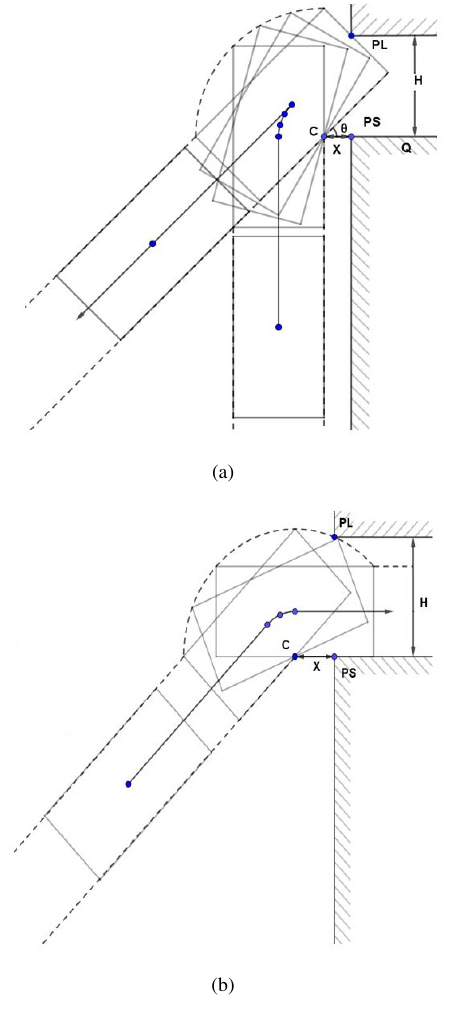
Figure 10. The trajectory of RRB when √ 0 <X< L 2 + W 2 − H 2